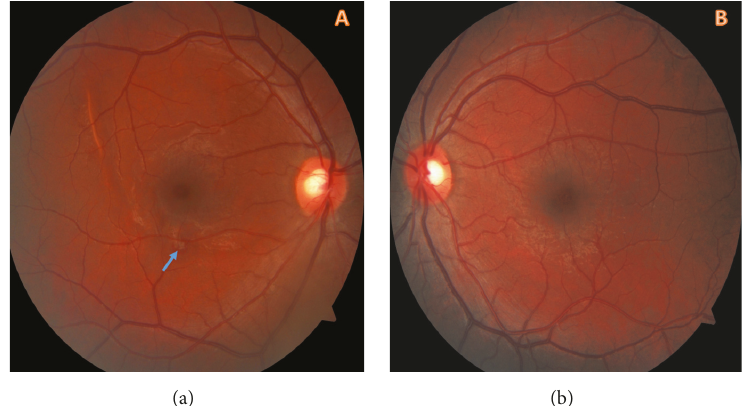
Figure 3: First month of examination of the patient. (a) All hemorrhages were resolved but RPE alterations were still seen at the margin of the inferior temporal arterial vascular arcade in the right eye (blue arrow). (b) Normal macula of the left eye.